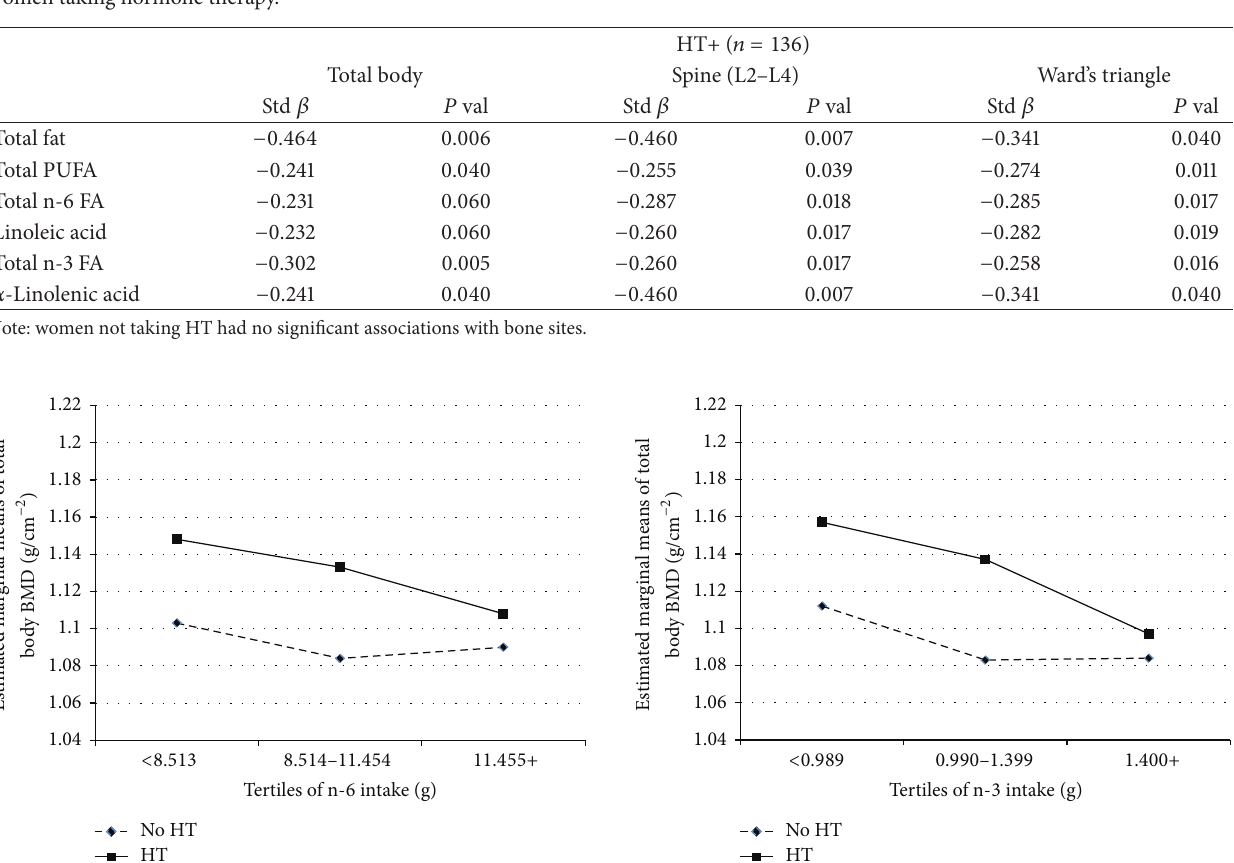
Table 3: One-year nutrient associations with bone mineral density by hormone therapy using multiple regression analysis in postmenopausal women taking hormone therapy.